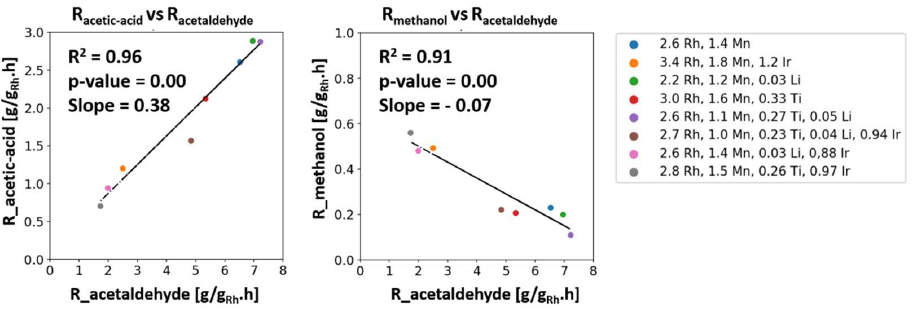
Figure 8. Scatter plots showing the correlation between R acetaldehyde and R acetic acid and between R acetaldehyde and R methanol , obtained in Exp 1 (T = 270 °C, P = 50 bar, total flow = 43 mL/min, H 2 :CO = 48:22 %V).